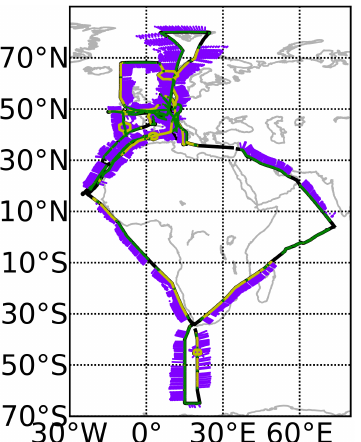
Figure 1. Overview over the flights performed during TACTS and ESMVAL. The flight paths are marked as black lines. Atmosphere measurements of GLORIA are overlayed in dark and light green for chemistry and dynamics mode, respectively. The tangent points of preliminarily processed profiles are shown in purple.